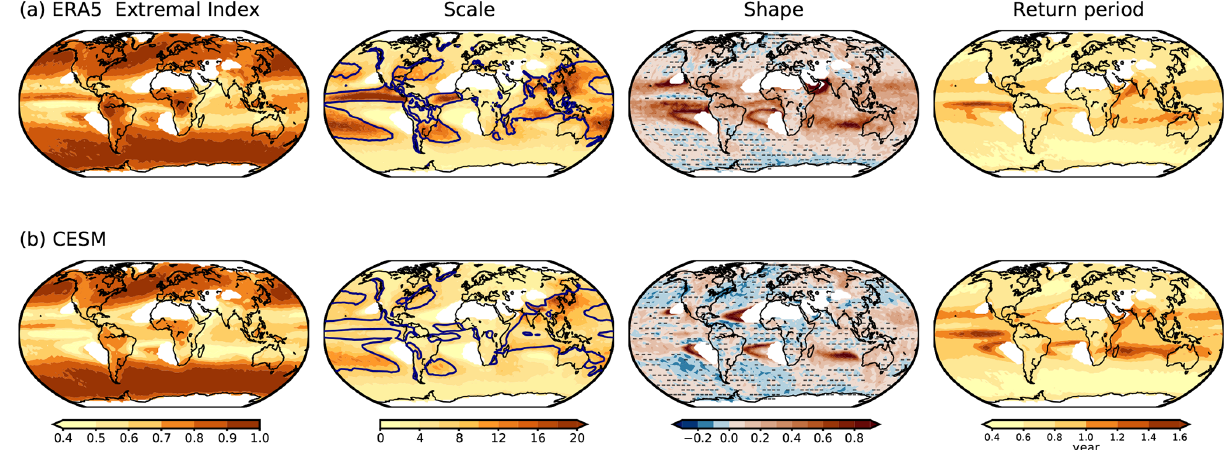
Figure 6. Extremal indices, parameters of the stationary GPD models, and return periods of the extreme thresholds in Fig. 5 for (a) ERA5 and (b) CESM. Striped regions indicate where the standard errors from the parameter estimation are higher than the estimated values. The dark blue line on the composite of the scale parameters denotes wet regions in Fig. 5. The regions where the annual total precipitation is less than 250mm are excluded from the analysis and marked as